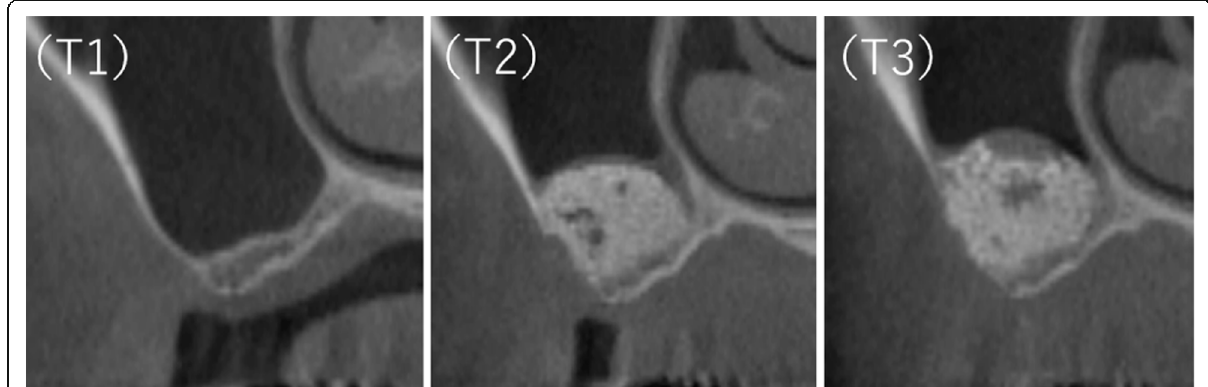
Fig. 1 CBCT images of the maxillary sinus: (T1) before surgery, (T2) immediately after surgery, and (T3) 6 months after surgery